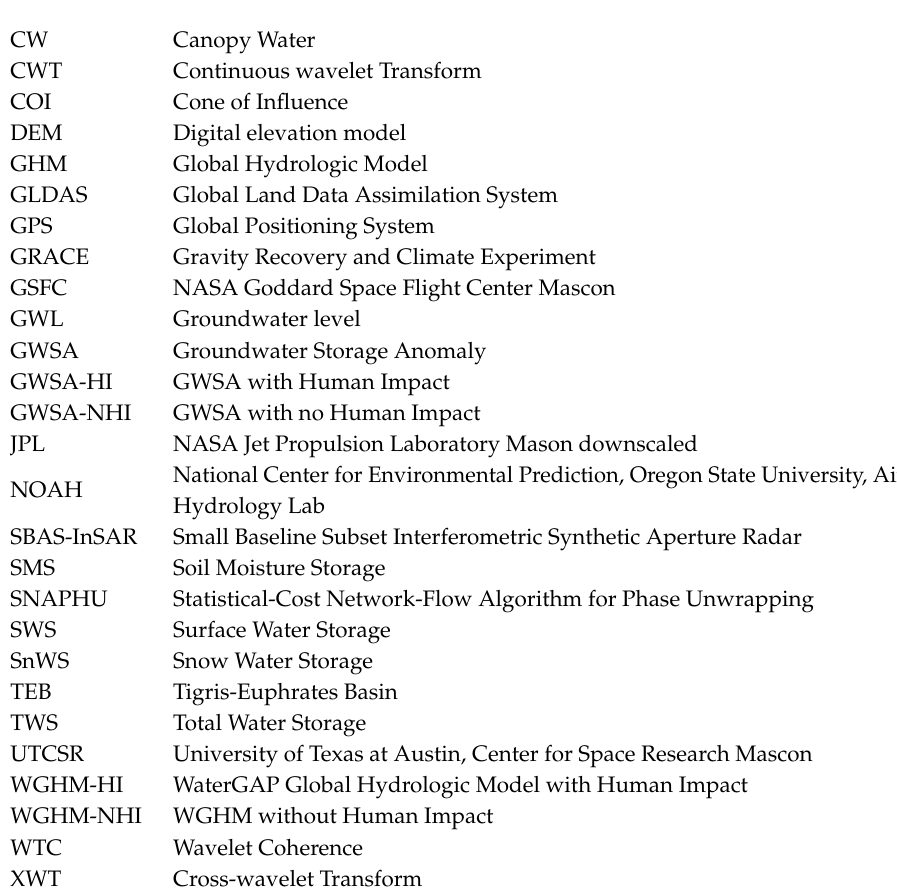
Figure S1: Monthly Discharge of Tigris river at Sarai Bagdad station